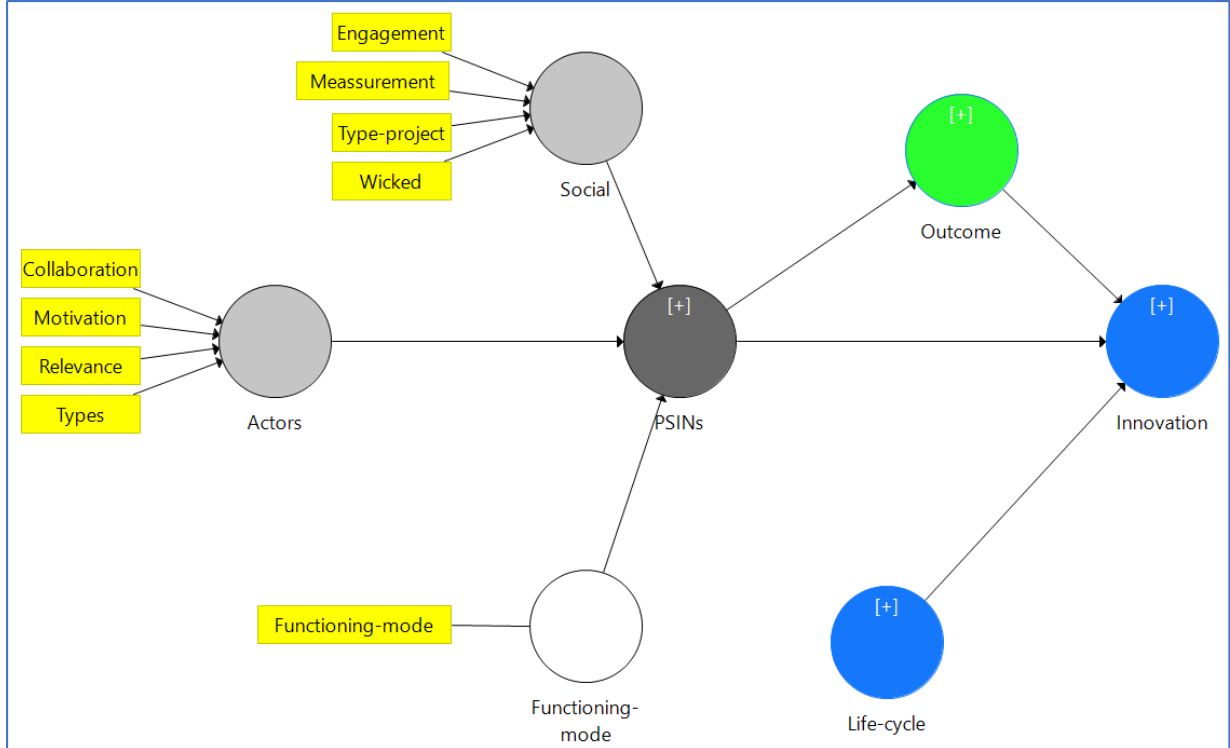
Figure 4. Second-order components (light-grey background) and third-order component (dark-grey background) of the PSINs model.